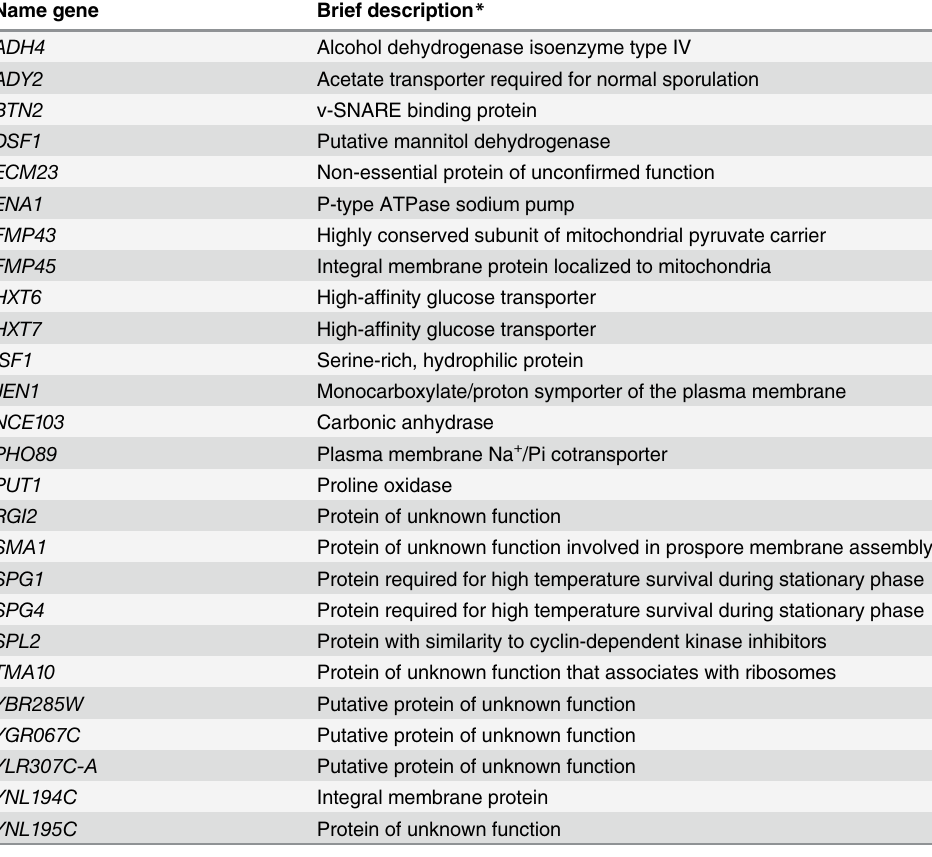
Table 2. Genes with lower expression levels in cells that harbored pTOW-Rear2 compared with the control